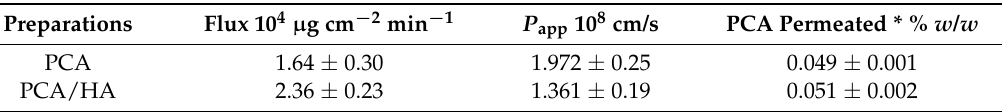
Table 2. Pharmacokinetic parameters for the ex vivo transcorneal permeation of -Oxo-2- pyrrolidinecarboxylic acid (PCA). Means ± SE, n = 6.